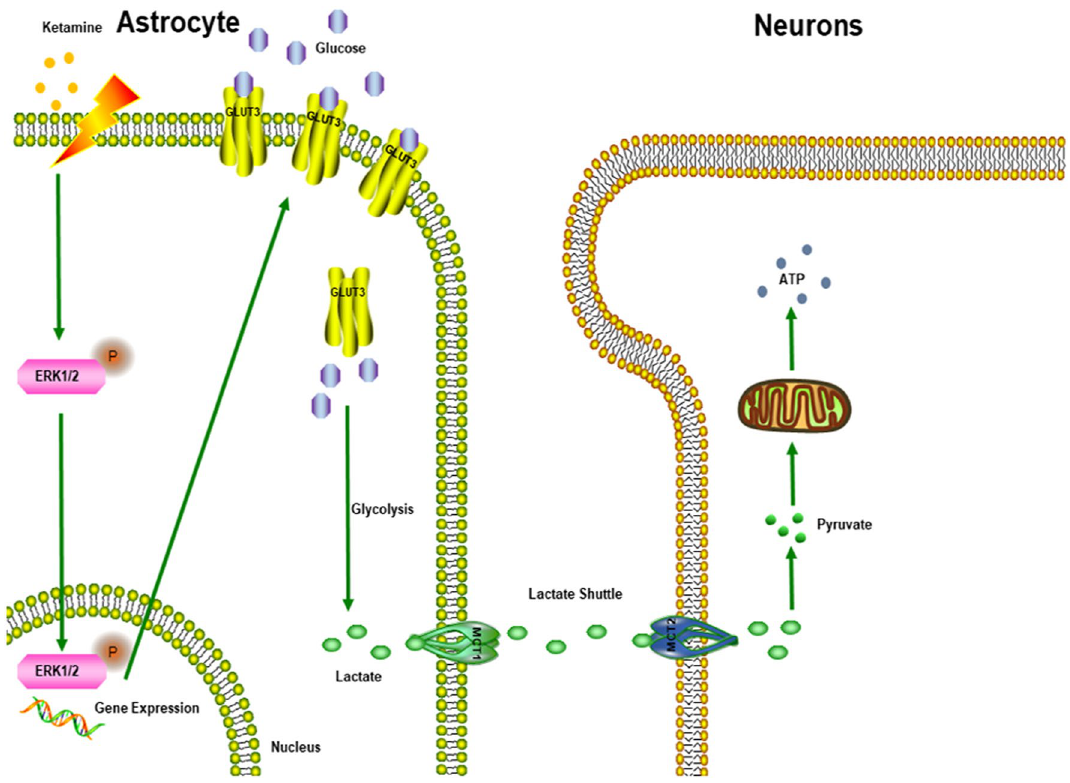
Figure 6. The ANLS (Astrocyte-neuron lactate shuttle)